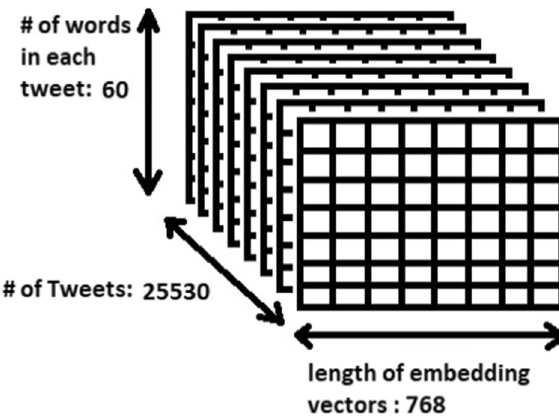
Fig. 3 3D arrays of preprocessed tweets before feeding to the